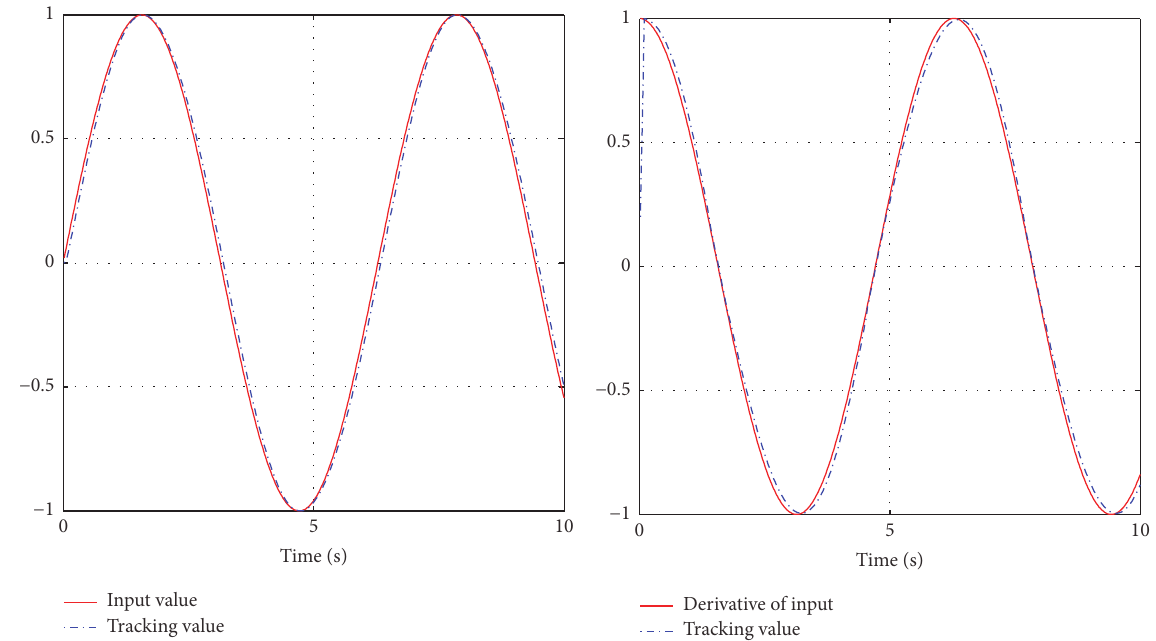
Figure 2: Tracking results of sinusoidal input and its